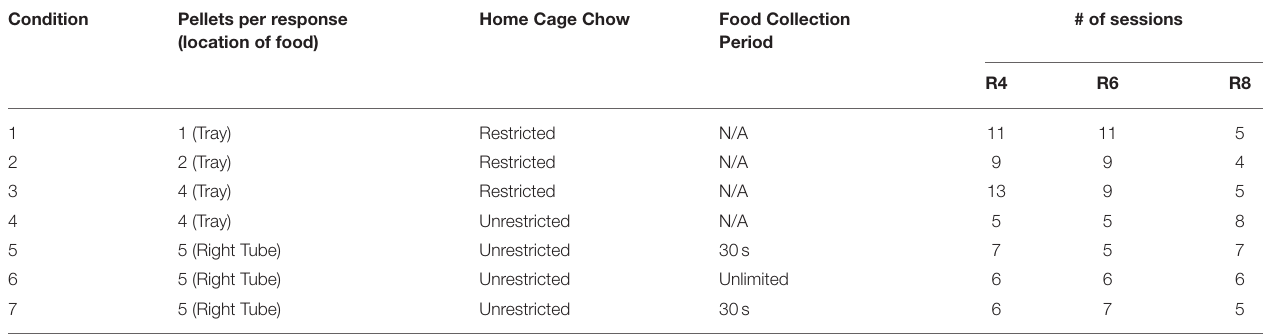
TABLE 1 | Sequence of conditions and number of sessions conducted at each. Condition Pellets per response Home Cage (location of food)